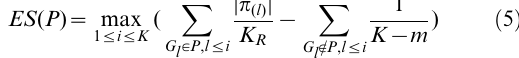
Table 3. Power of the methods as the proportion of pathway SNPs with effects